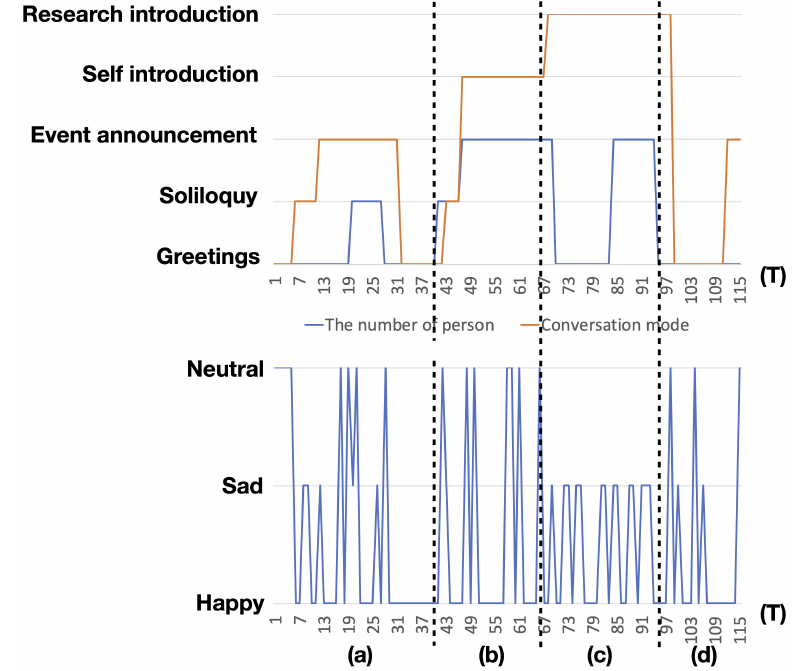
Figure 17. The conversation mode transition results of the interaction.